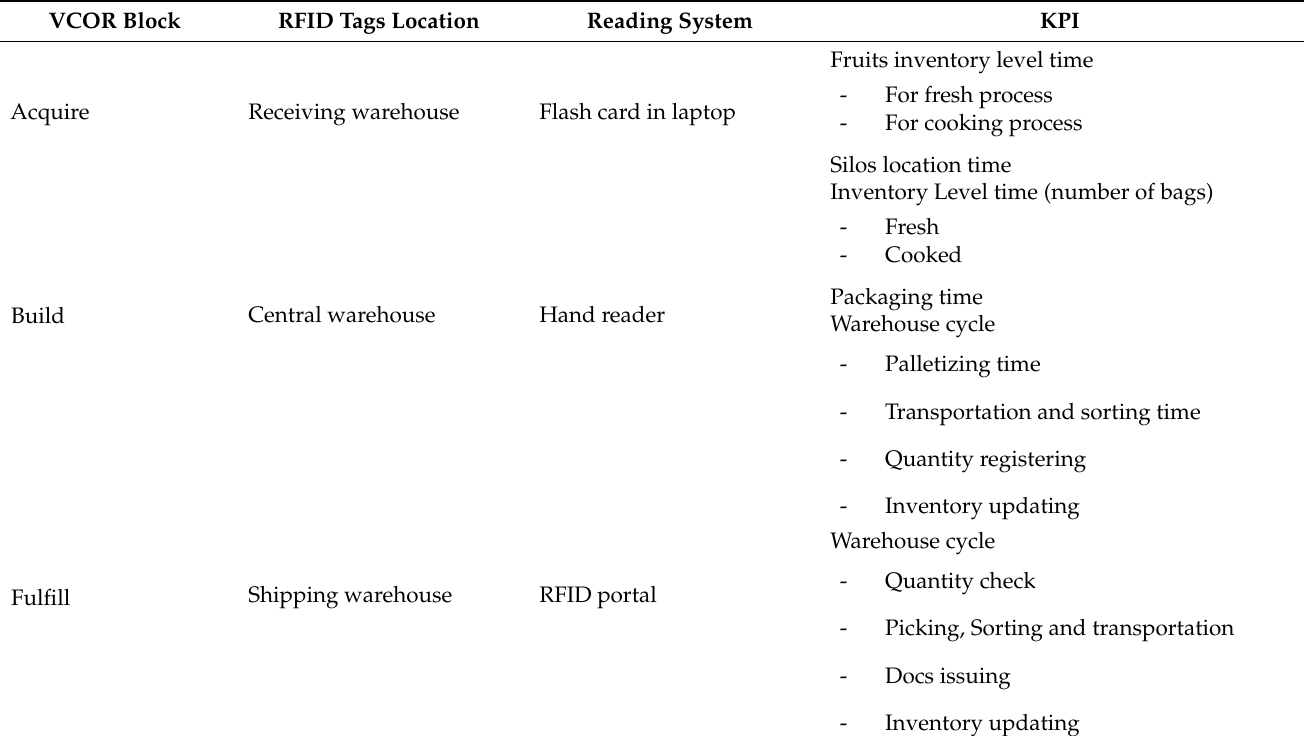
Table 6. Devices locations and KPI